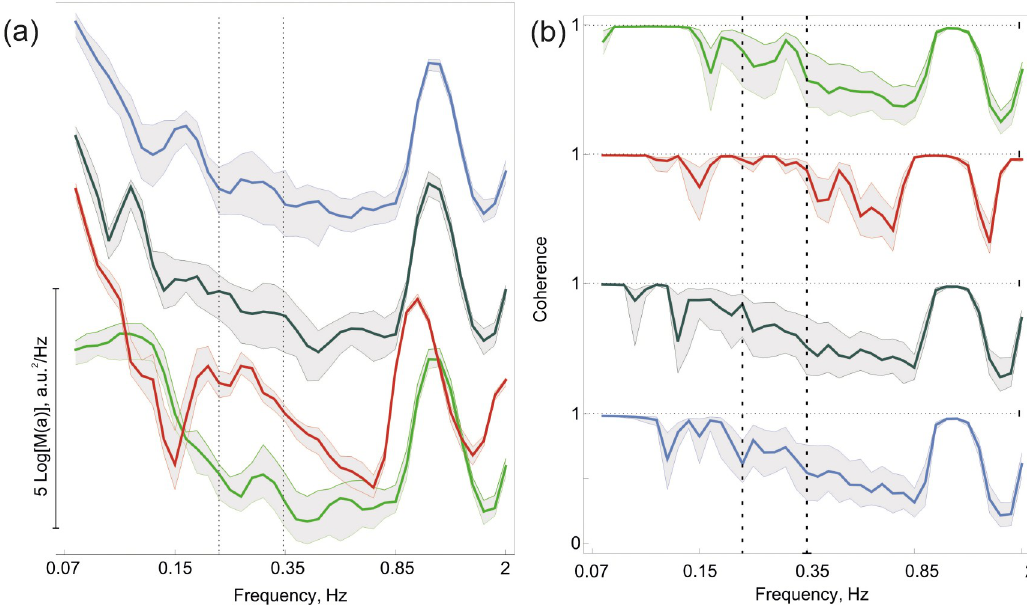
Fig 6. Spectra (a) and coherence (b) in 4 time intervals. Green curves—LSCI perfusion before the BHT , red—during the test, gray—transitional period, blue—recovered perfusion 1.5 min after the BHT . The color scheme is the same as in Fig 5.